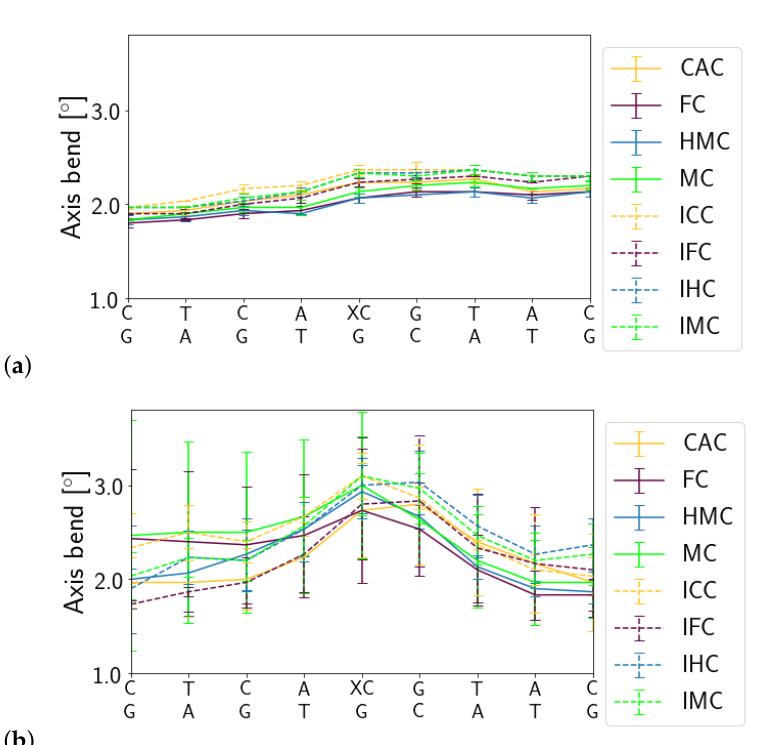
Figure 5. Helical axis bend of ( a ) free DNA and ( b ) complexed DNA.